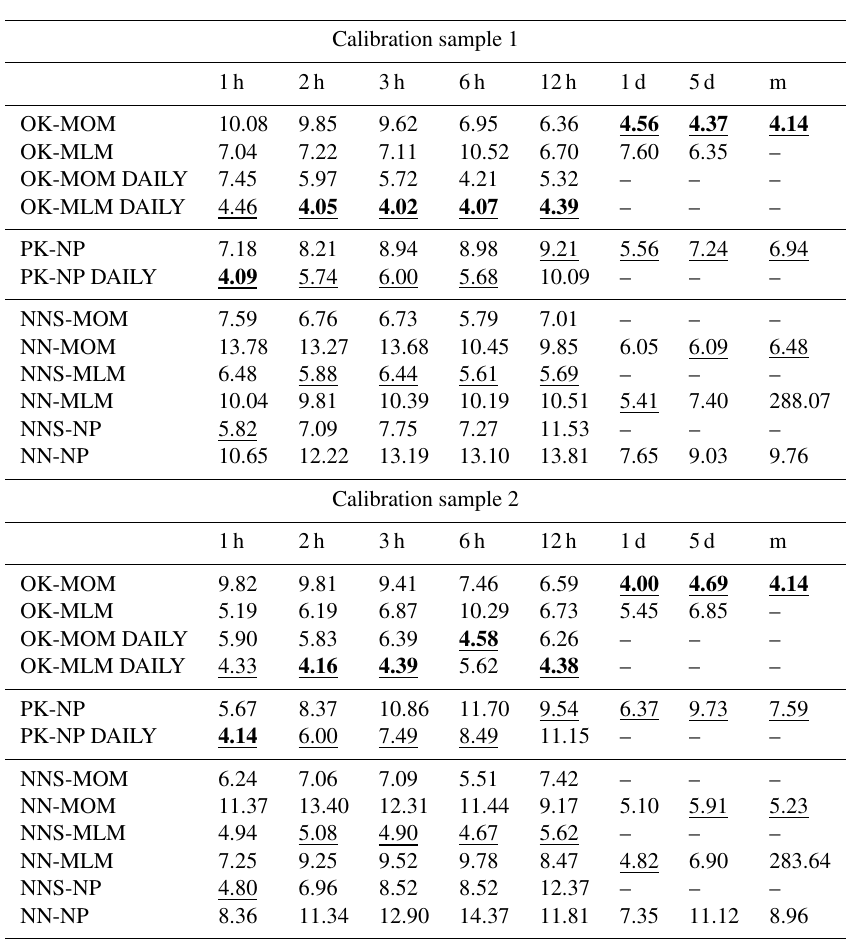
Table 5. The performance ranking numbers for the 2-fold cross-validation of the regionalized precipitation amount models in the winter season. The underlined numbers indicate the best parametric (P) and nonparametric (NP) models. The bold numbers indicate the best overall model for each validation sample and temporal